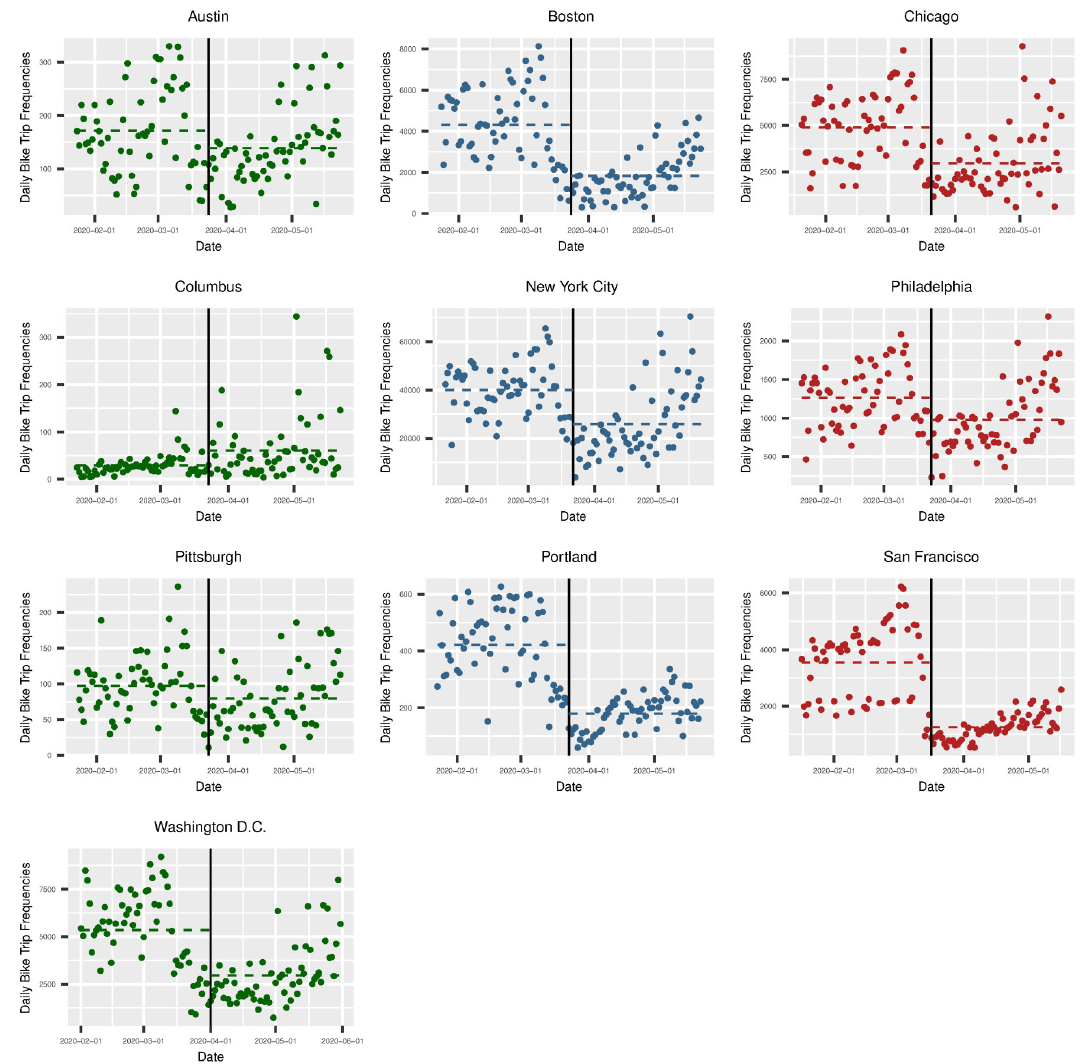
Fig 2. Frequency of bike-sharing platform trips over time, before and after the first executive order